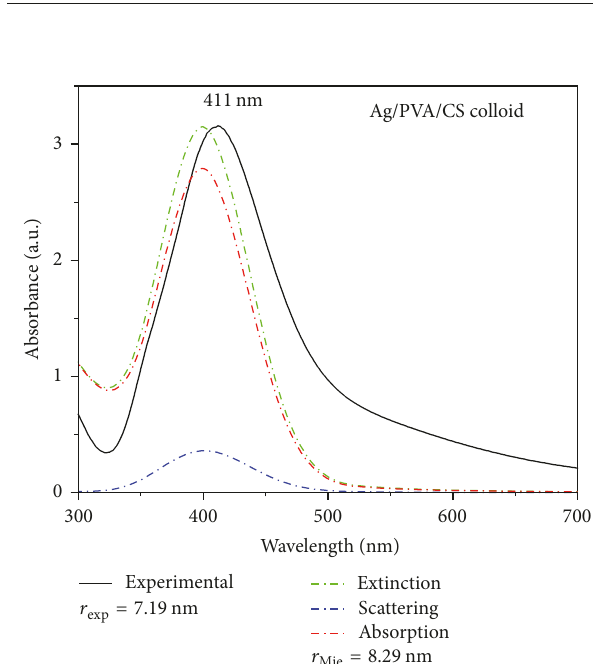
Figure 4: UV-Vis absorption spectra of Ag 101 colloid suspension. The solid line corresponds to the experimental spectrum and the dashed lines correspond to the calculated simulation spectra using the Mie